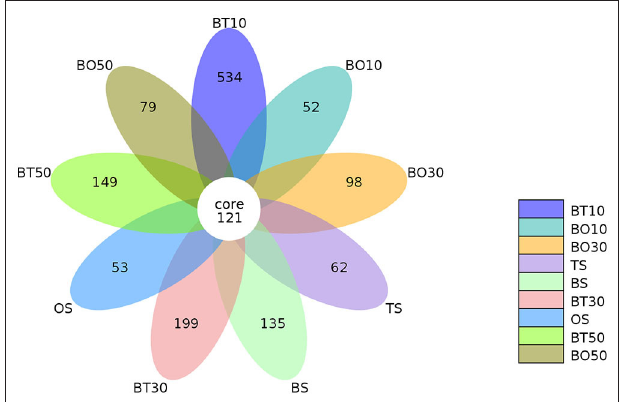
FIGURE 3 | Petal diagram analysis of operational taxonomic units. FT, fresh forage wheat; FB, fresh faba bean; FO, fresh oat; BS, 100% faba bean silage; OS, 100% oat silage; TS, 100% forage wheat silage; BO10, 10% faba bean with 90% oat mixed silage; BO30, 30% faba bean with 70% oat mixed silage; BO50, 50% faba bean with 50% oat mixed silage; BT10, 10% faba bean with 90% forage wheat mixed silage; BT30, 30% faba bean with 70% forage wheat mixed silage; BT50, 50% faba bean with 50% forage wheat mixed